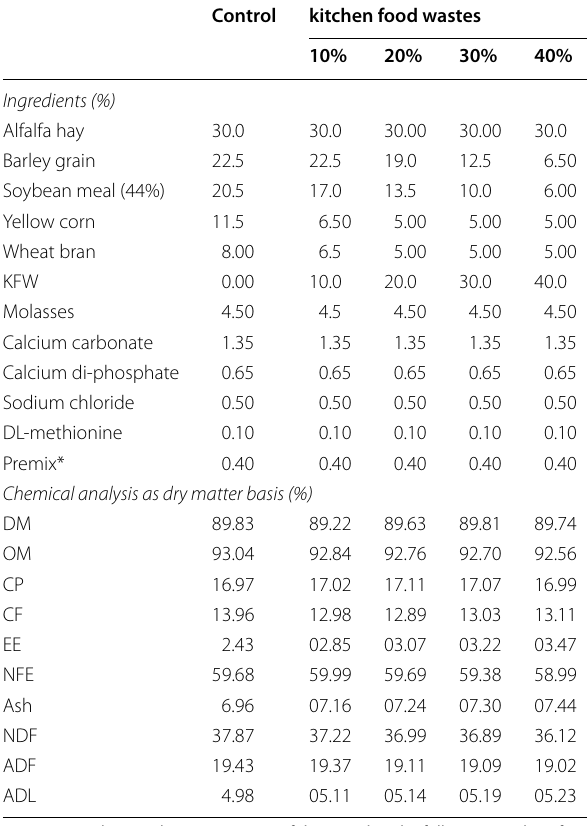
Table 1 Composition and chemical analysis of experiment diets